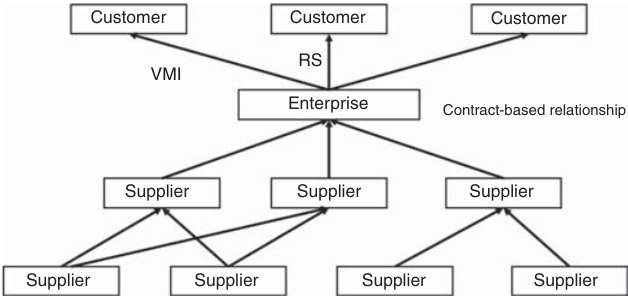
Figure 2. Supply chain model in the